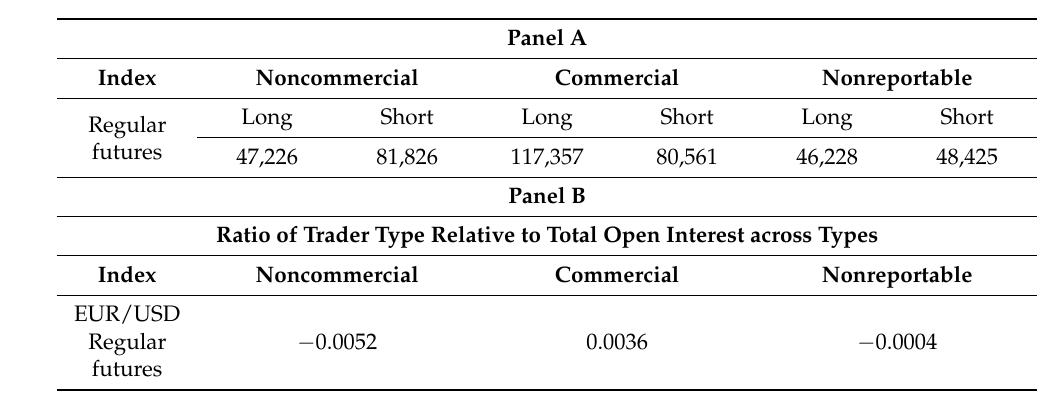
Table 2. Summary statistics of Commodity Futures Trade Commission (CFTC) positioning